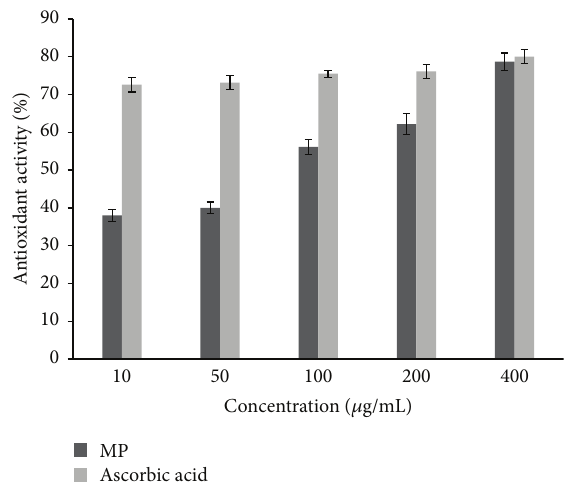
Figure 2: Percent antioxidant activity of MP using DPPH.